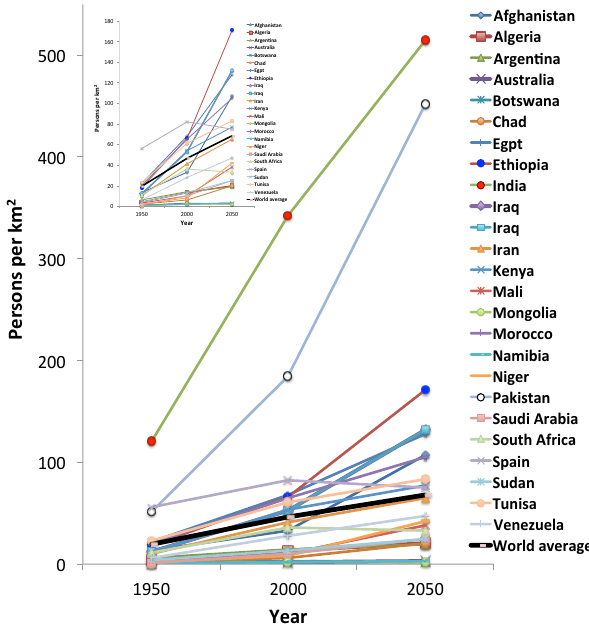
Fig. 1. Average global population density growth and population density growth for dryland dominated countries (defined as where Figure 1.1451 dryland areas are larger than 50% of the total areas). The in- set represents the same information but excludes India and Pak- istan for better display of the other countries. The population data is from the Department of Economic and Social Affairs of the United Nations (2004). http://www.un.org/esa/population/